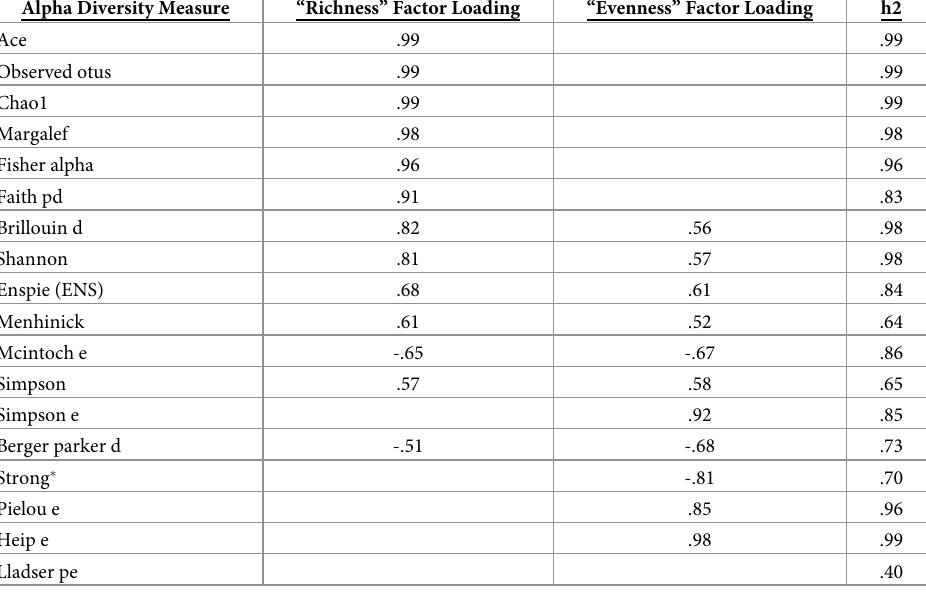
Table 6. Results of the exploratory factor analysis with all observed alpha diversity